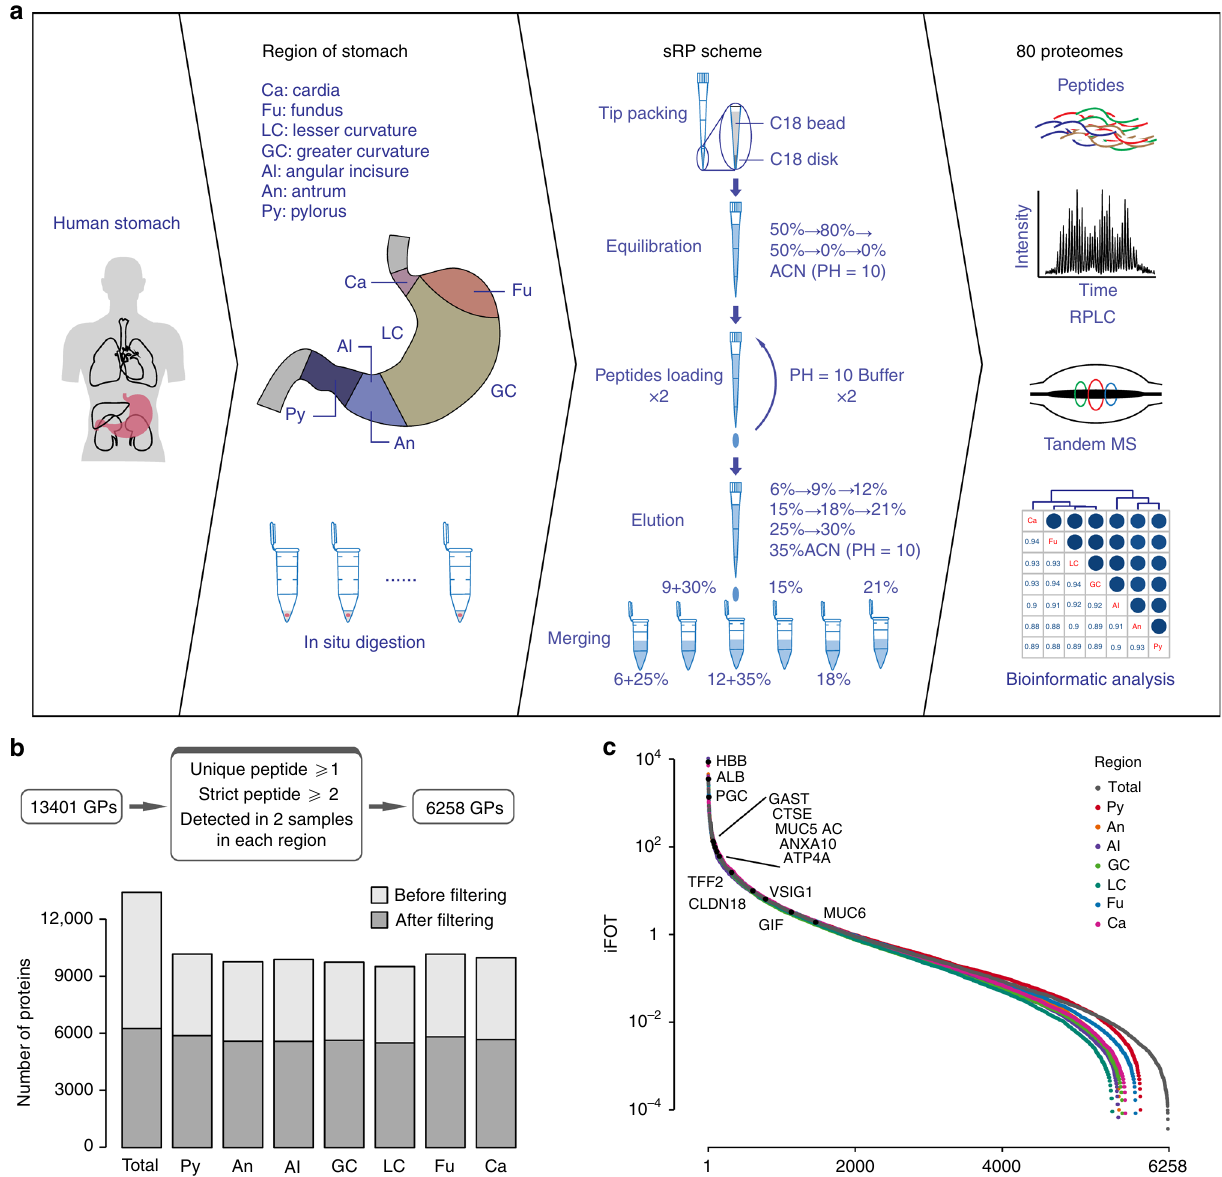
Fig. 1 A brief summary of proteomic analysis of human gastric mucosa. a Illustration of sample collection, preparation, and LC – MS/MS. Human mucosa tissue samples were collected from seven antonymic stomach regions by gastro-endoscope. Mucosa tissues were in-solution digested with trypsin, and the resulting peptides were separated by sRP-RP prior to LC – MS/MS analysis. b A total of 13,401 GPs were identi fi ed in all 82 samples at 1% peptide-level FDR. Further screening generated 6258 high-con fi dence proteins that were detected with at least one unique peptide and two strict peptides in a minimum of two samples in one region. Light gray displays the number of GPs before fi ltering; dark gray shows the number of GPs after fi ltering. c The dynamic ranges of mucosa proteomes and several high- and low-abundant gastric